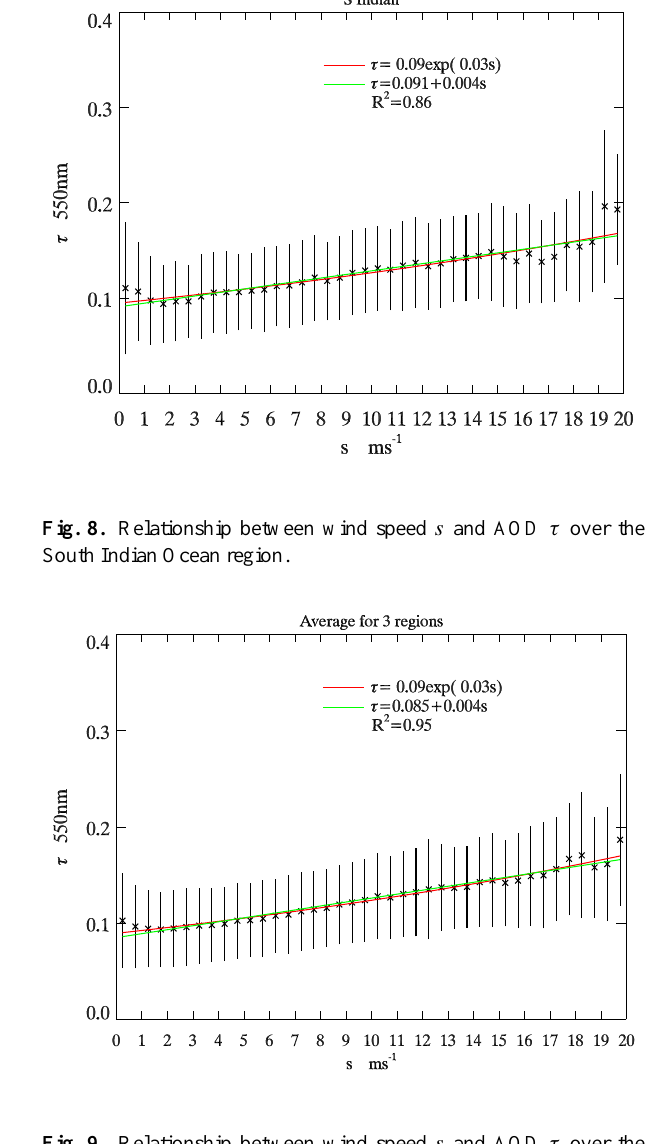
South Atlantic ocean region. Fig. 7. Relationship between wind speed s and AOD τ over the